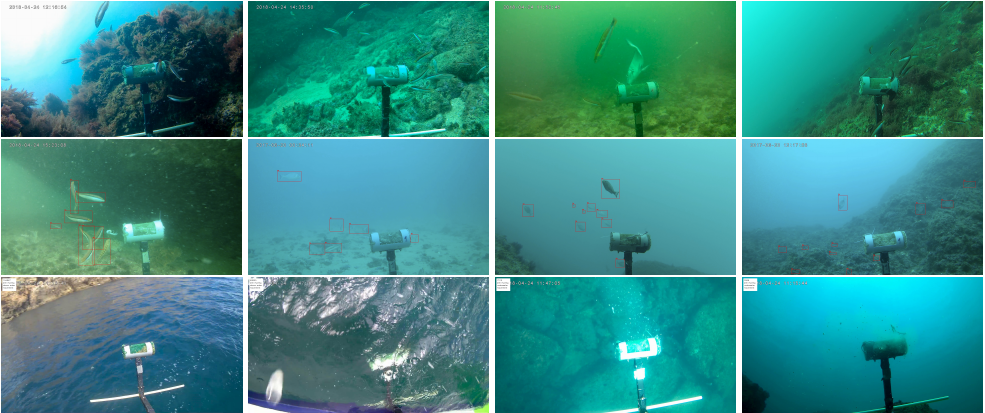
Figure 2. Top row: sample of CCMAR unlabeled footage. Middle row: ground-truth annotations of CCMAR videos. Bottom row: negative sample images obtained from the video classification